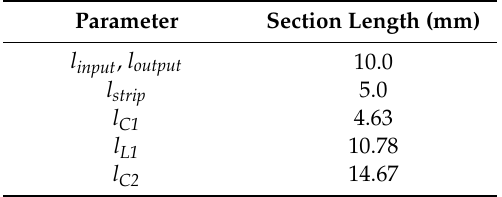
Table 5. Stripline heterogeneous filter section